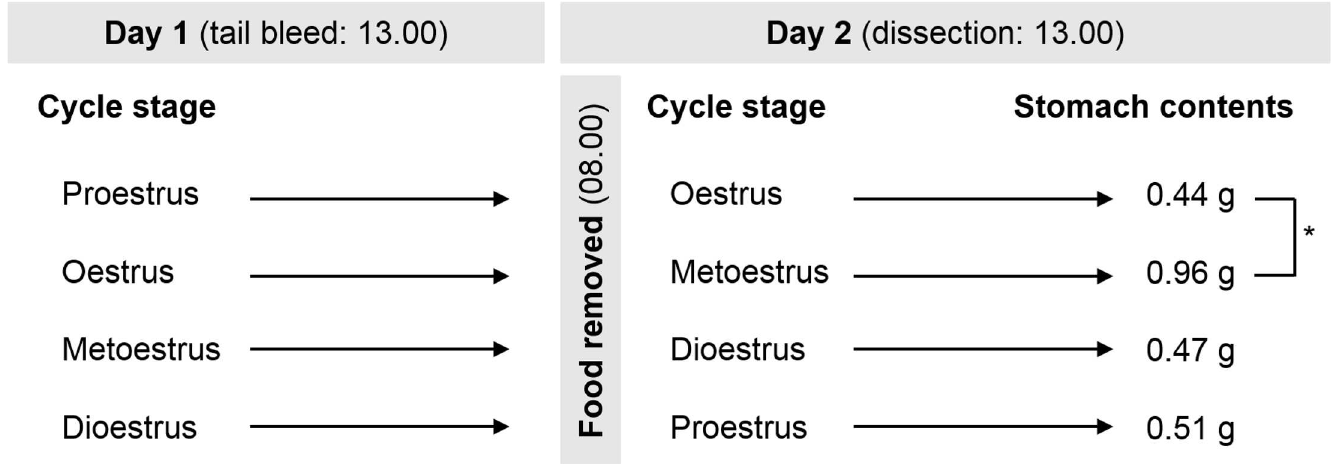
Fig 1. The mass of fasted stomach contents after each stage of the oestrous cycle. The reducedstomach contents seen after proestrus/oestrus was significantly less than after oestrus/metoestrus, indicatingreducedearlier food and water consumption. (Cull cycle stages: proestrus, n = 12; oestrus, n = 11; metoestrus, n = 9; dioestrus, n = 11. * P < 0.05).